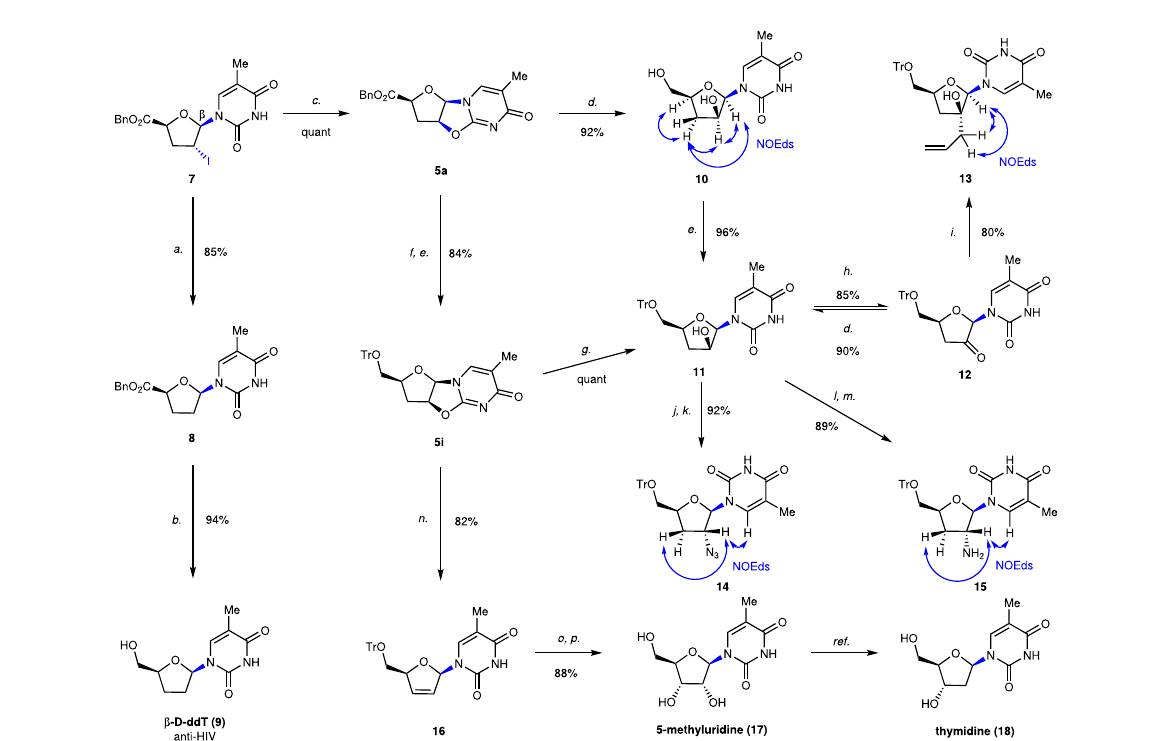
85%; i . allylmagnesium bromide (1.0M in THF), THF, – 78°C, 80%; j . MsCl, Et 3 N, DMAP, CH 2 Cl 2 , rt.; k . NaN 3 , DMF, 80°C, 92% over two steps; l . PPh 3 , DEAD, phtha- limide,THF,rt; m .N 2 H 4 ·H 2 O,EtOH,50°C,89%overtwosteps; n . t -BuOK,DMSO,rt., 82%; o . OsO 4 , NMO, acetone:H 2 O=4:1, rt.; p . 80% AcOH aq., 50°C, 88% over two